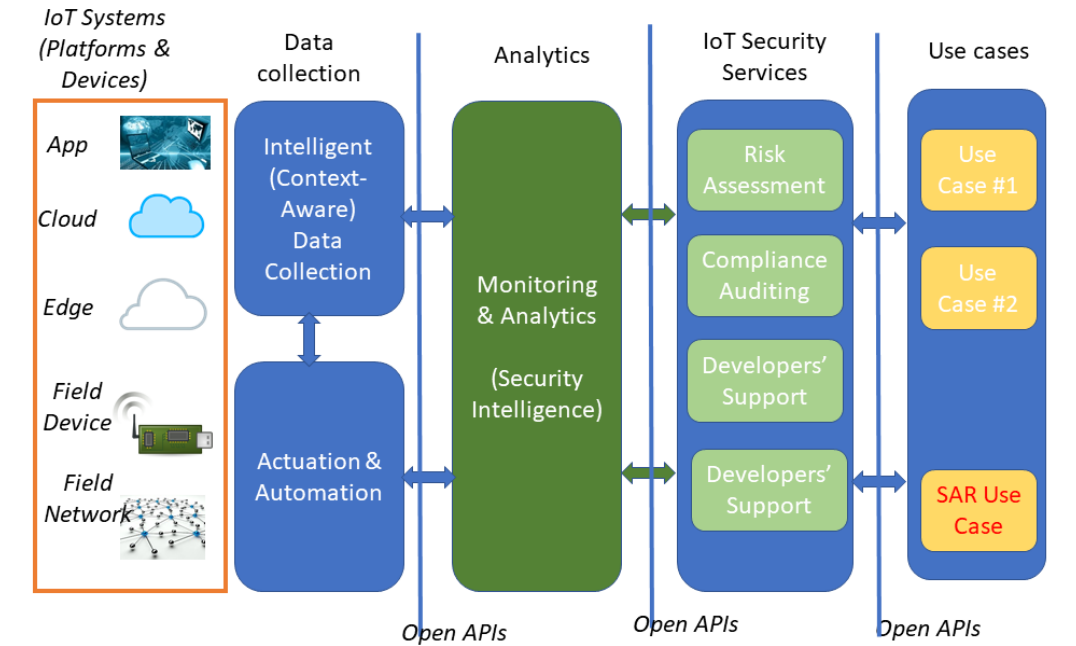
Figure 1. Secure IoT Architecture